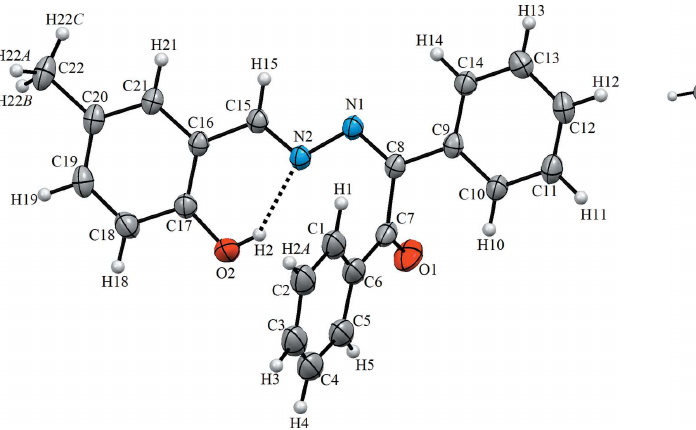
Figure 2 A view of the crystal packing of the title compound. Blue dashed lines denote the intermolecular C3—H3 (cid:2)(cid:2)(cid:2) O2 hydrogen bonds forming an inversion dimer (Table 1).